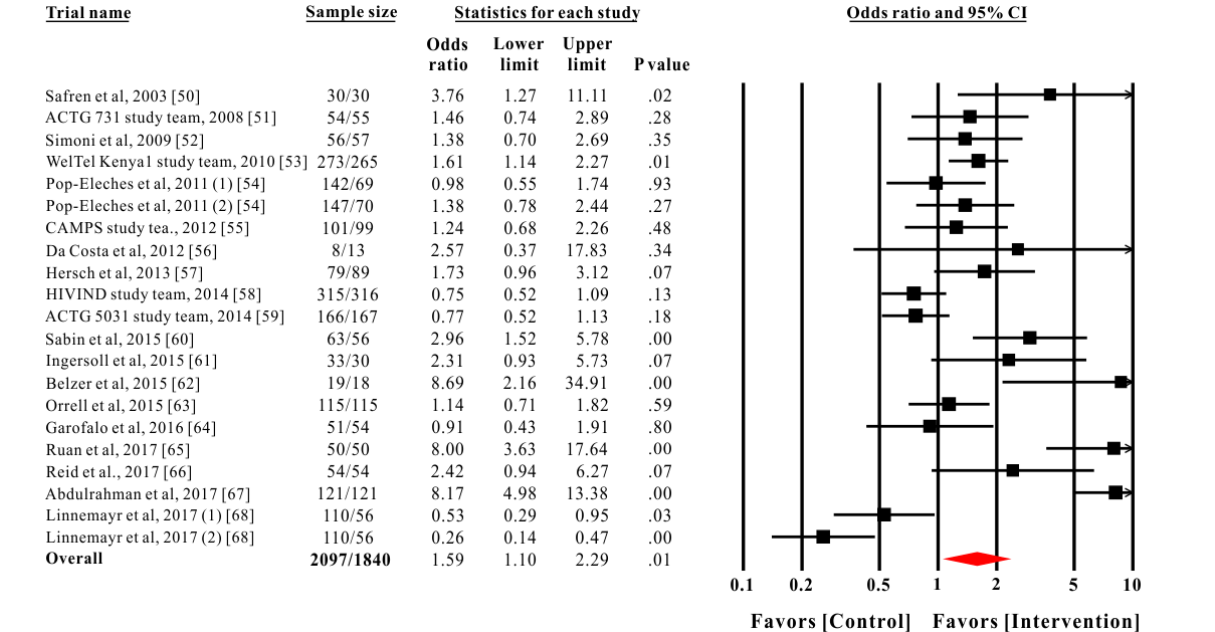
Figure 2. The effect of electronic health intervention on antiretroviral therapy adherence of people living with HIV. Two independent comparison trials (daily short message service [SMS] and weekly SMS) from the study of Pop-Eleches et al were extracted as Pop-Eleches et al (1) and Pop-Eleches et al (2), and two independent comparison trials (1-way and 2-way communication strategies) from the study of Linnemayr et al were extracted as Linnemayr et al (1) and Linnemayr et al